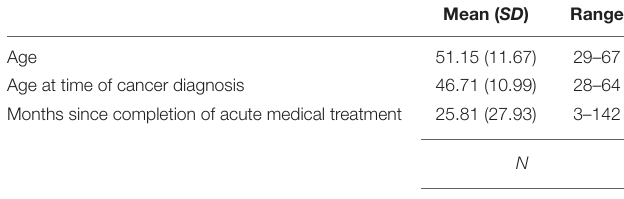
TABLE 1 | Participant